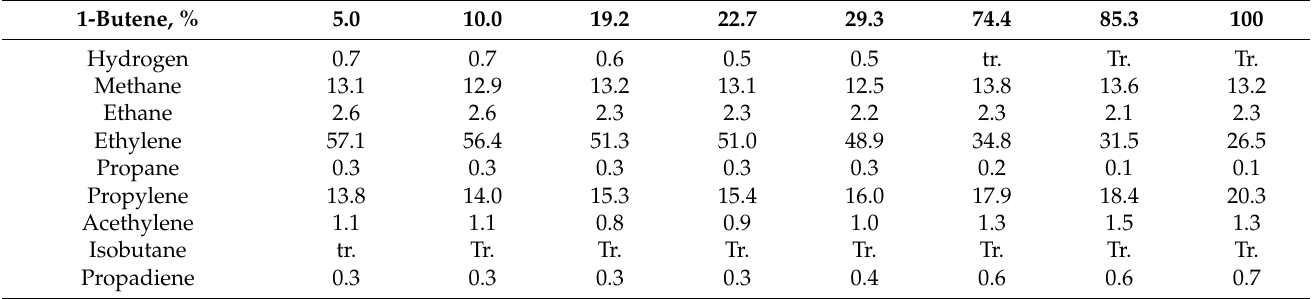
Table 3. Co-pyrolysis of 1-butene and n-hexane at 820 ◦ C. Composition of reaction mixture after co-pyrolysis (in columns: content of 1-butene in the